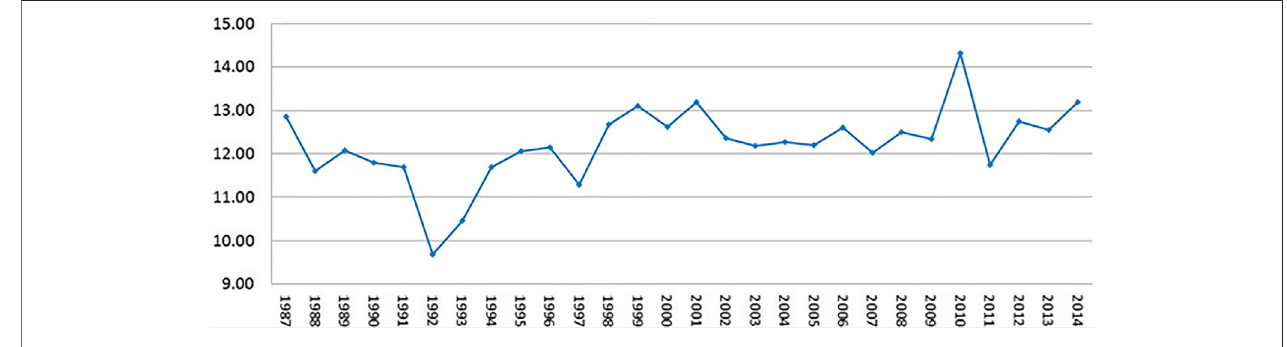
FIGURE 6 | Temperature changes in LU basin from 1987 to